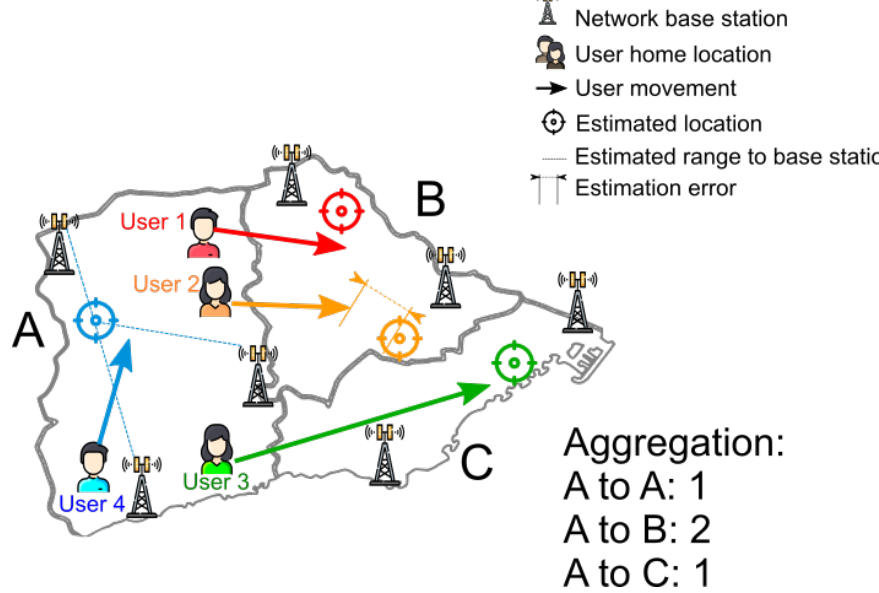
Figure 2. Measurement of mobility among geographical